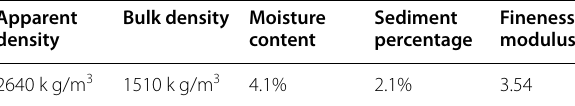
Table 3 Performance indexes of manufactured sand test Apparent density